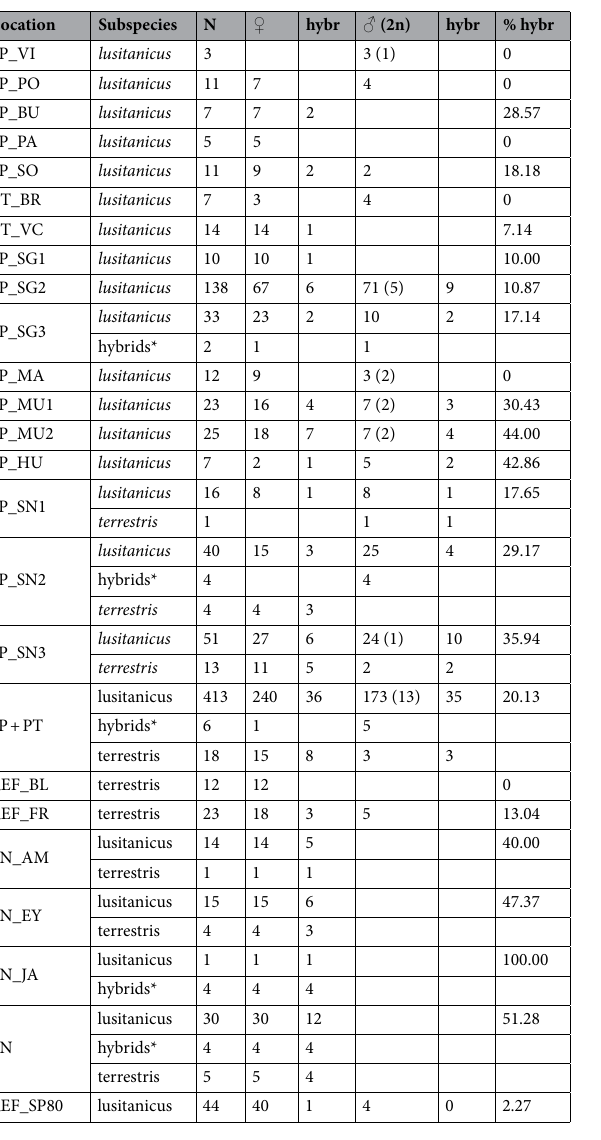
Table 1. Subspecies identification of B. terrestris individuals and hybrids detected per location (see Supplementary Table S1 online for location codes). Hybrids have been identified either morphologically (labelled with * in the subspecies column) or through discrepancies between morphologic identification and mitochondrial haplotype (hybr. column). Samples have been separated by sex, showing the number of diploid males (2n) in parentheses. The percentage of hybrid individuals (morphological and mitochondrial) is shown by sampling site. N = sample